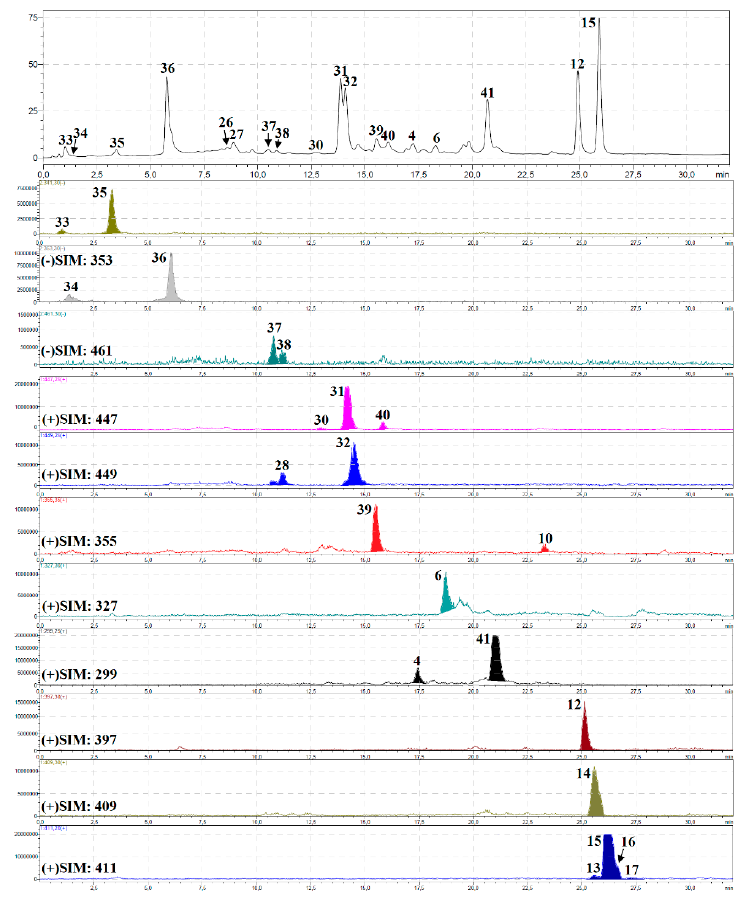
Figure 4. HPLC-DAD chromatogram (330 nm; ( a ) and some HPLC-ESI-MS chromatograms (SIM mode, positive/negative ionization; ( b ) of methanol extract of P. sibiricus herb. Compounds are numbered as listed in Table 2.